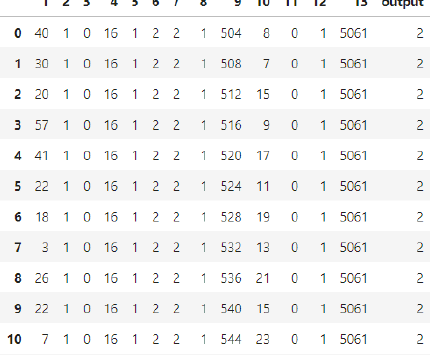
Figure 5. The Numerical Format of the Dataset.